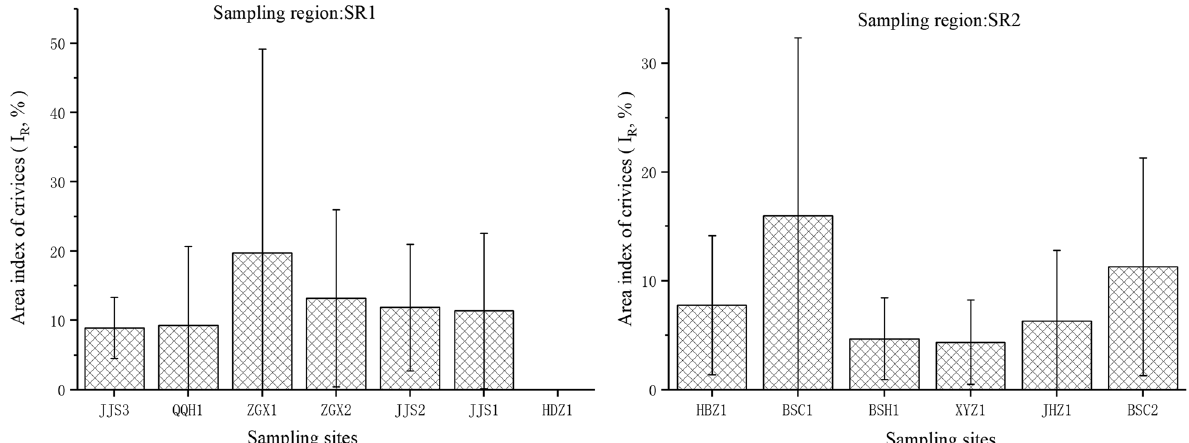
Table 2 COV and BM on 13 RCSs in study regions of west Sichuan, China Region: SR1 Region: SR2